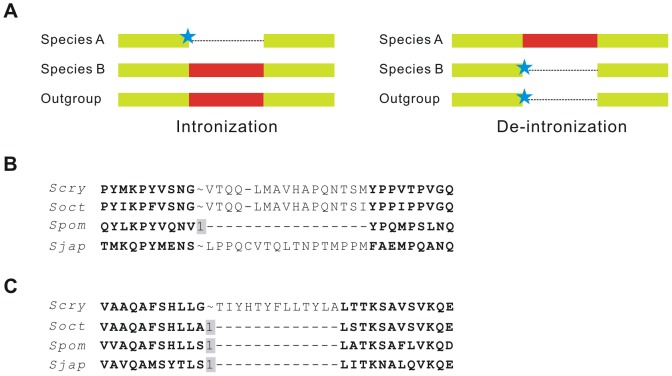
Detection of intronization and de-intronization.Both intronization and de-intronization are characterized by introns neighboring large gaps while the surrounding coding regions remain well aligned. These two can be distinguished by the presence or absence of the introns in other outgroup species (A). The conserved surrounding coding regions are marked in yellow and the exonized or intronized regions are marked in red. Introns are represented as stars. The protein alignments show a case of intronization in S. pombe (B) and a case of de-intronization in S. cryophilus (C). Intron phases are marked as 0, 1, 2 or ∼ (absence of an intron). Species names abbreviations: S. cryophilus (Scry), S. octosporus (Soct), S. pombe (Spom), and S. japonicus (Sjap).